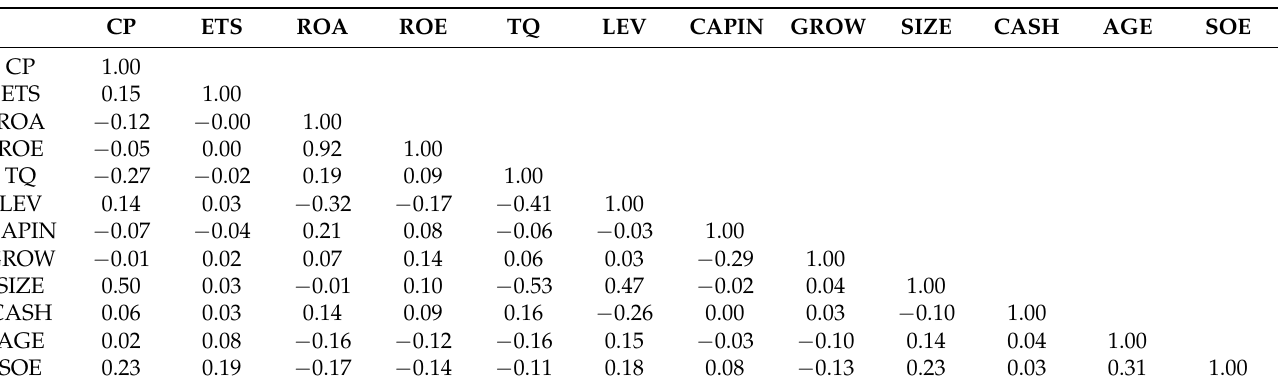
Table 6. Correlation matrix.